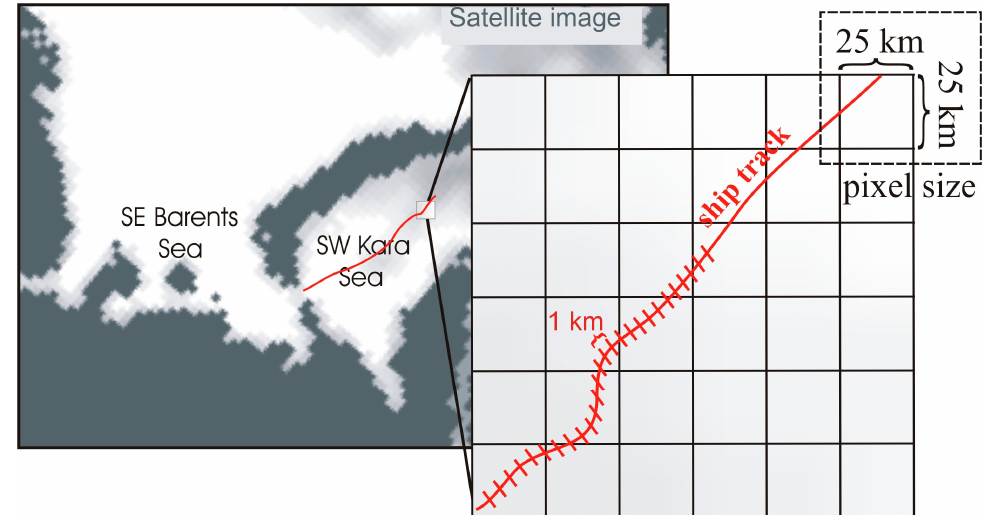
Figure 3. Schematic illustration of matching the ship and the satellite microwave SIC data.